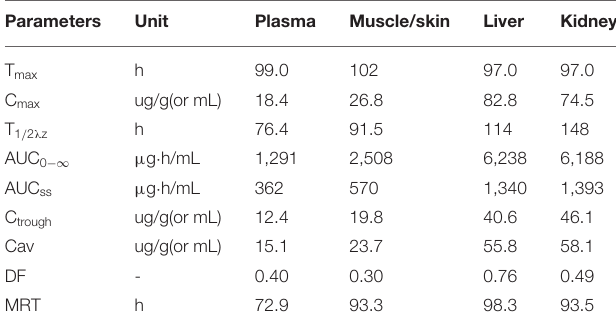
TABLE 3 | Pharmacokinetic parameters of enrofloxacin in the plasma and tissues of crucian carp after oral administration of multiple doses (20 mg/kg b.w., for five consecutive doses, with an interval of 24h between each dose) at 28 ◦ C (Time from the first dose). Parameters